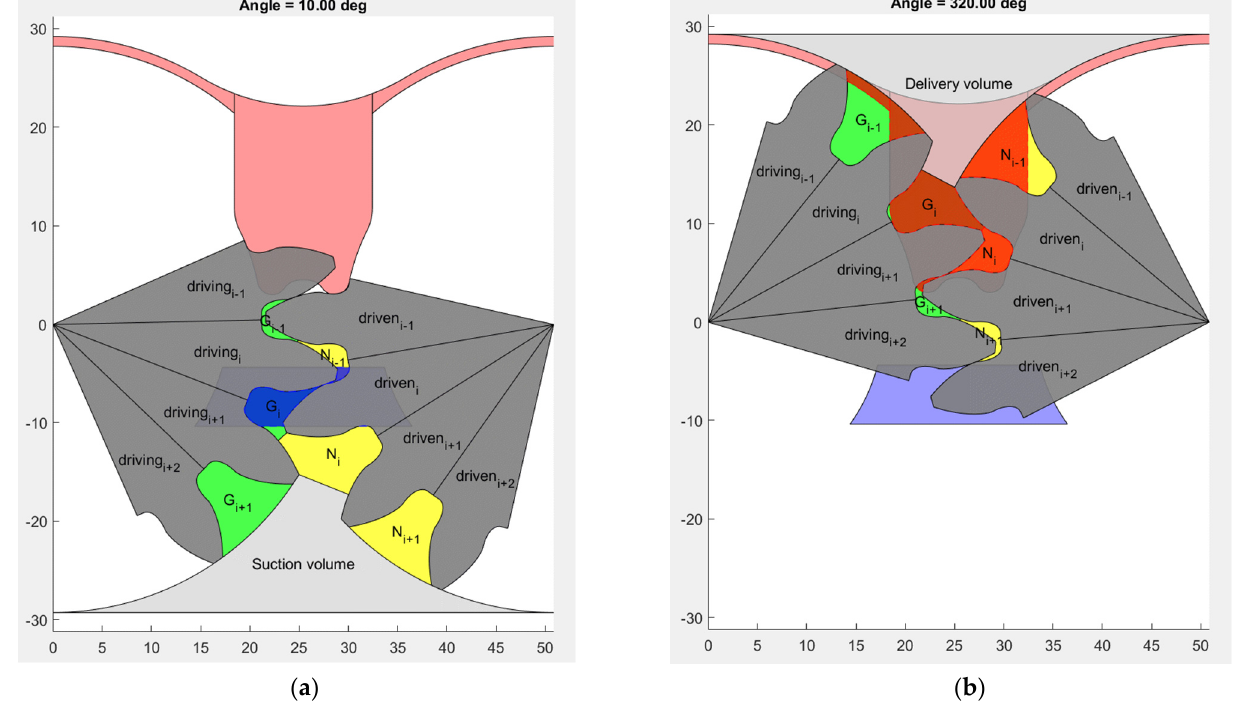
Figure 4. Extracted frames from the GIF animation at: ( a ) 10 deg of rotation; ( b ) 320 deg of rotation.